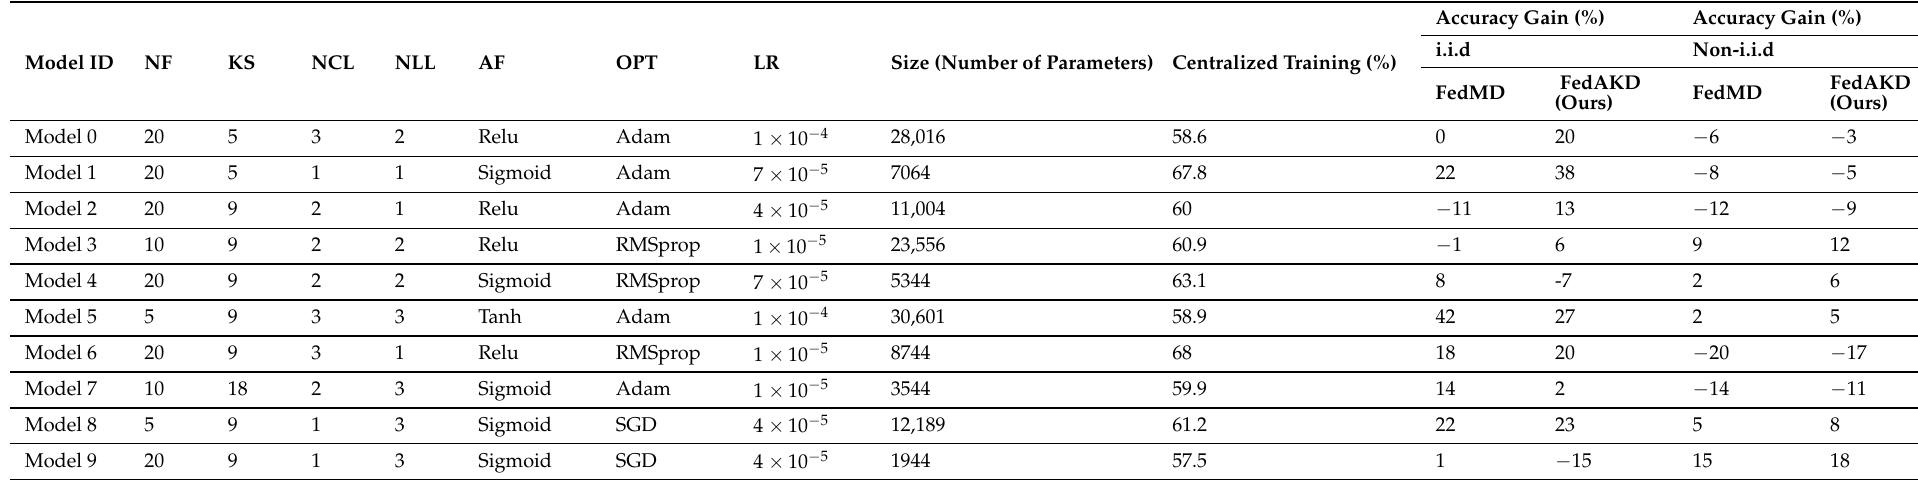
Table 3. Architecture details of the deep learning models participating in the HARB dataset FL experiment.